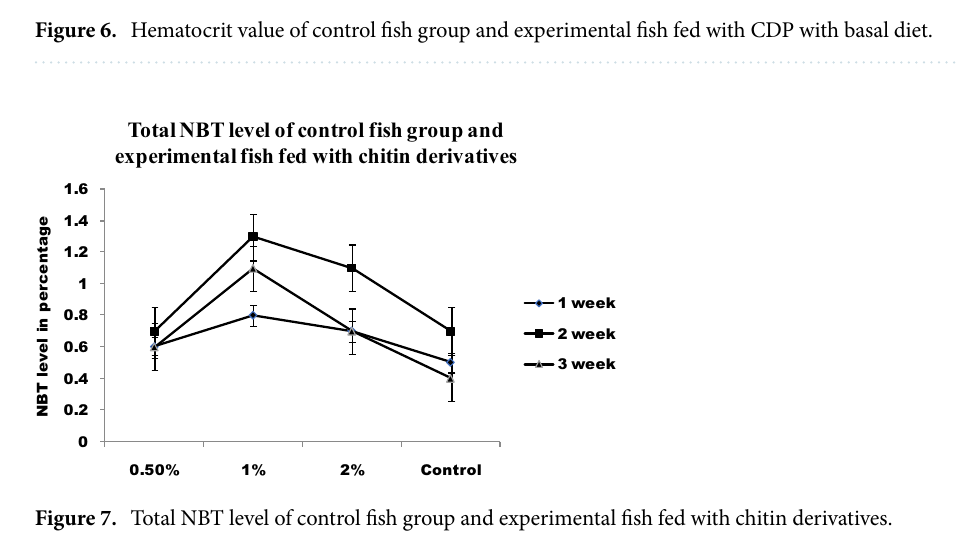
Figure 7. Total NBT level of control fish group and experimental fish fed with chitin derivatives.